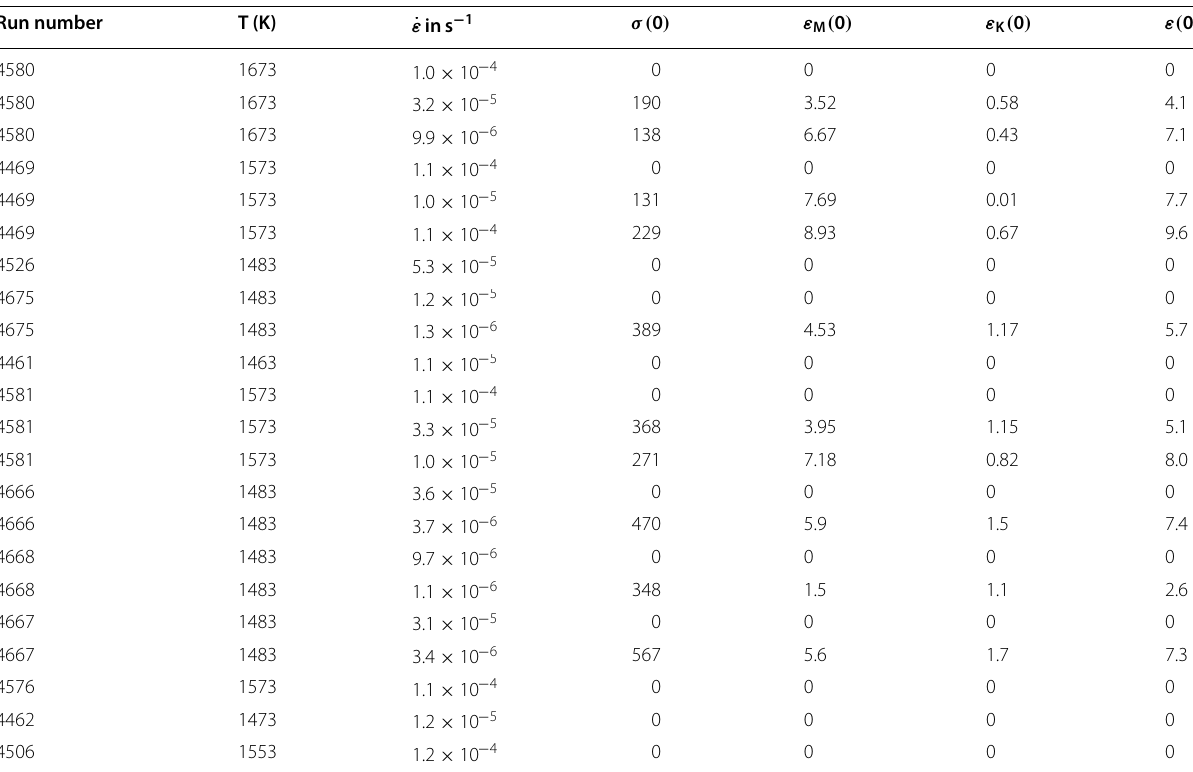
Table 1 Experimental setting for dry dunite deformation from Chopra and Paterson (1984). All the stress-versus-strain series are available from their supplementary material. The initial conditions used to solve the ordinary differential equation for the MCMC inversion and the best-fit model are provided